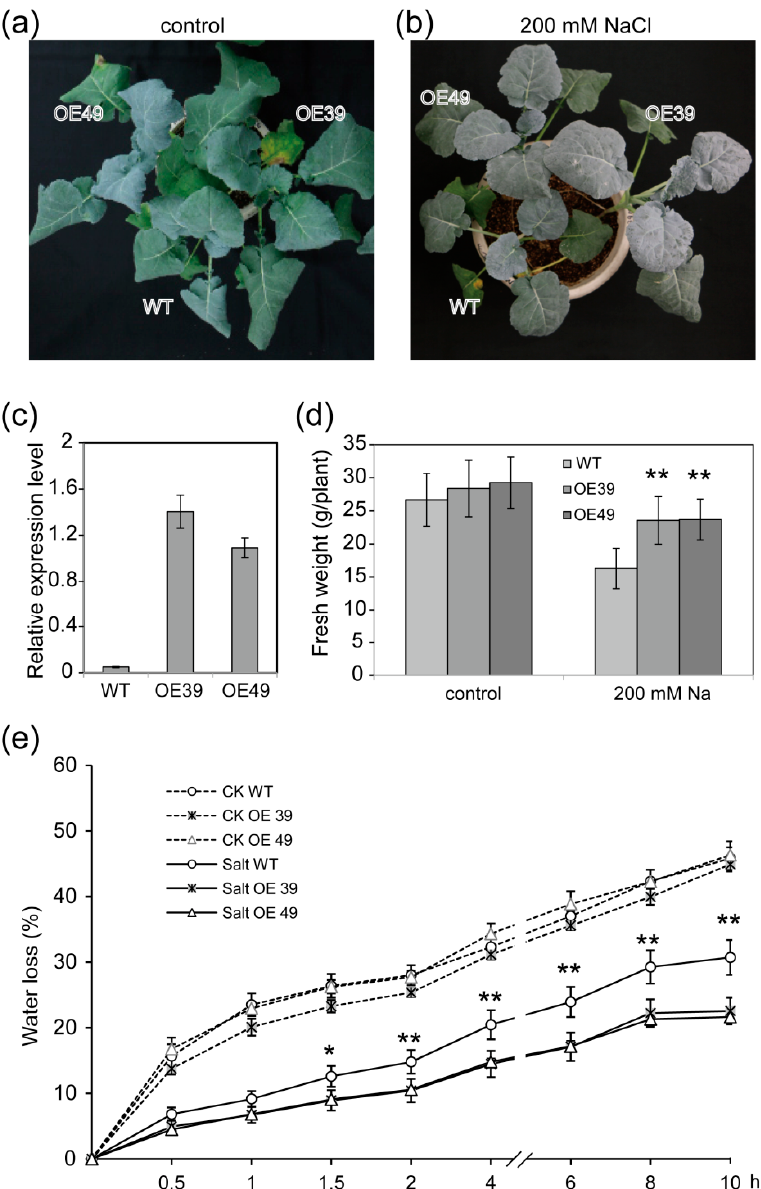
Figure 2. Overexpression of BnWIN1 enhanced plants growth and reduced water loss under salt stress. ( a , b ) The phenotype of BnWIN1 -overexpression (OE) plants under control and salt stress conditions. Forty-day-old plants grown in soil in pots were treated with 200 mM NaCl for 30 days. ( c ) The BnWIN1 expression level of BnWIN1 -OE plants confirmed by real-time PCR with β -Actin as an internal standard. Values are means ± SD ( n = 3 separated samples). ( d ) Enhanced growth of BnWIN1 -OE plants under salt stress. Forty-day-old plants grown in soil in pots were treated with 200 mM NaCl for 30 days, and fresh weight was measured. Values are means ± SD ( n = 12 plants). ( e ) Water loss from detached leaves. Values are mean ± SD ( n = 3 independent experiments). * and ** indicate significant difference at p < 0.05 and p < 0.01 , respectively, compared with wild type (WT) plants based on Student’s t test.